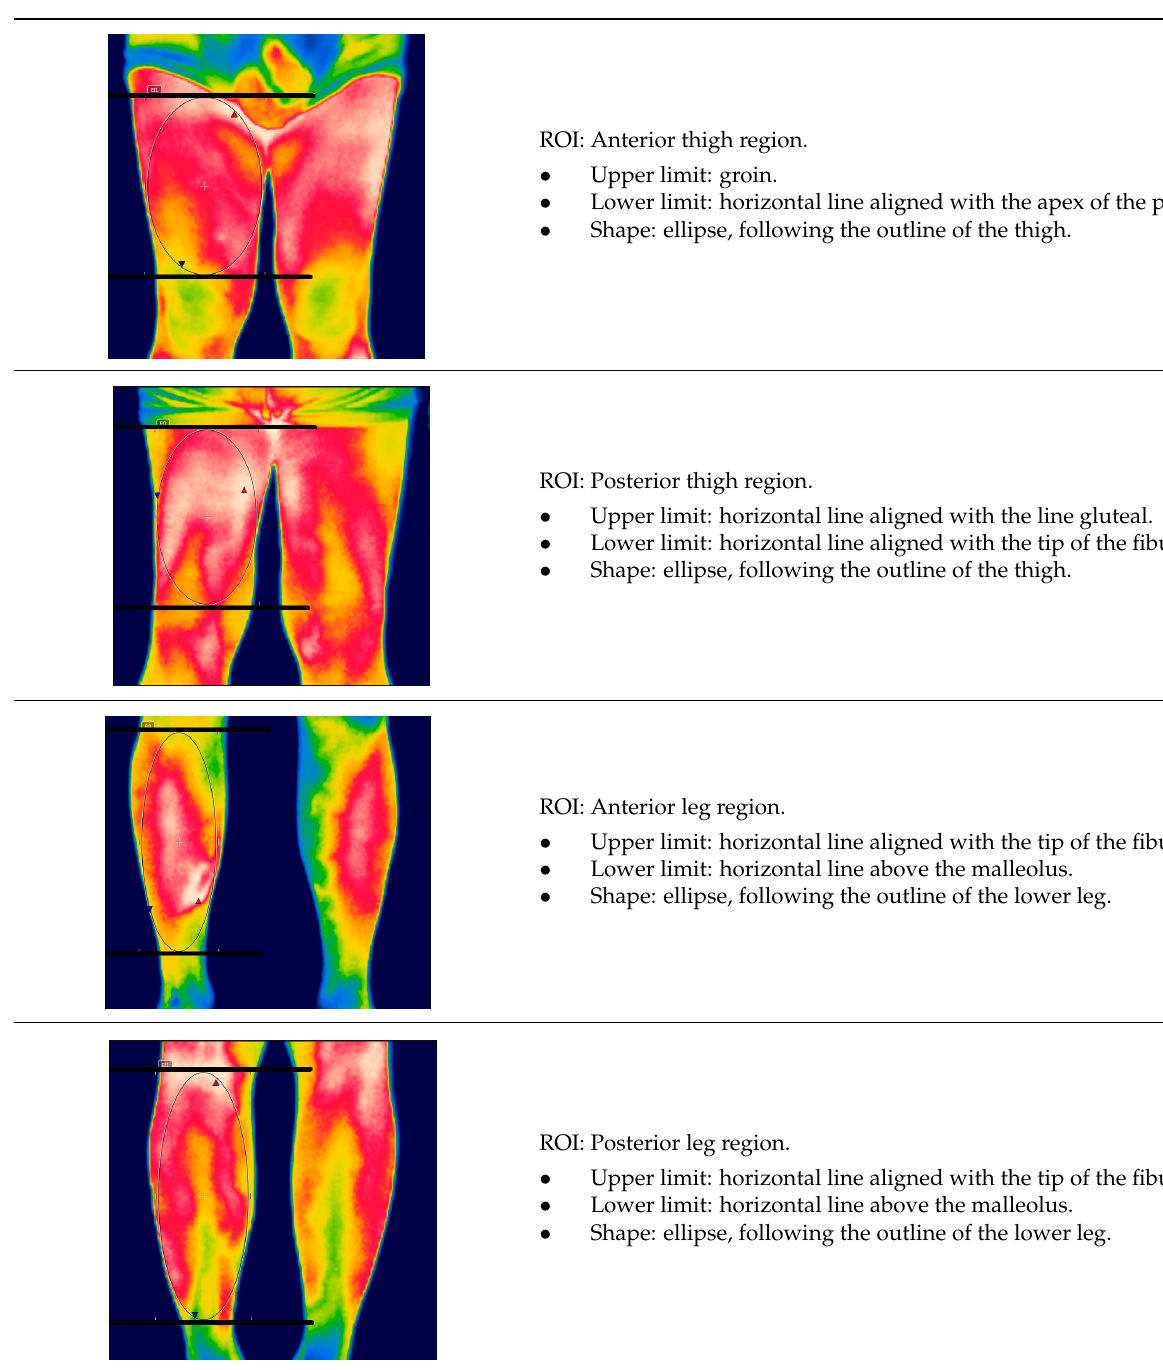
Table 3. Regions of interest (ROI) to be analyzed.